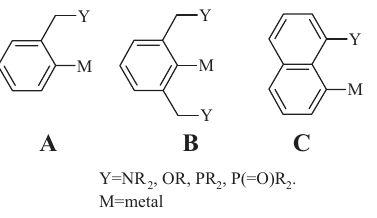
Figure 2 Organometallic compounds containing C, Y- or Y, C,Y- chelating ligands.